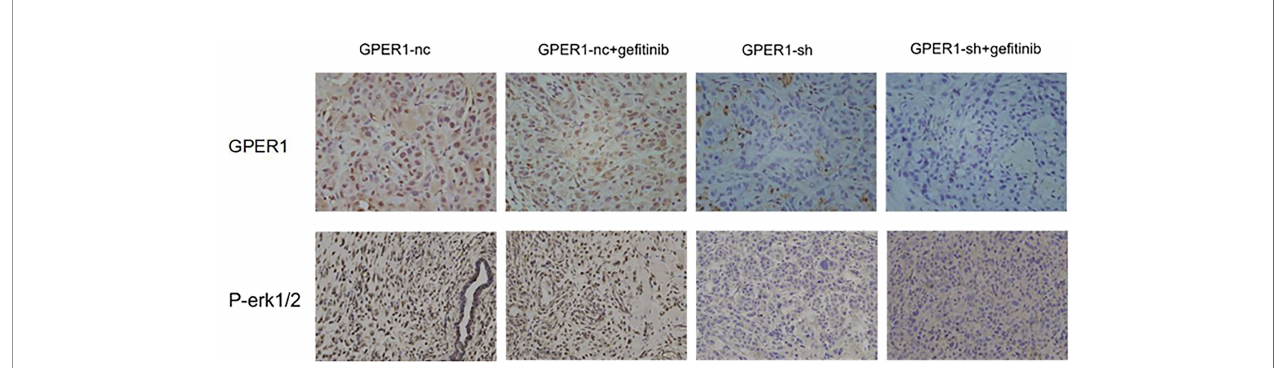
FIGURE 8 | Knockdown of GPER1 decreased the level of p-ERK in vivo . GPER1 negative control short hairpin RNA (GPER1-nc), GPER1 short hairpin